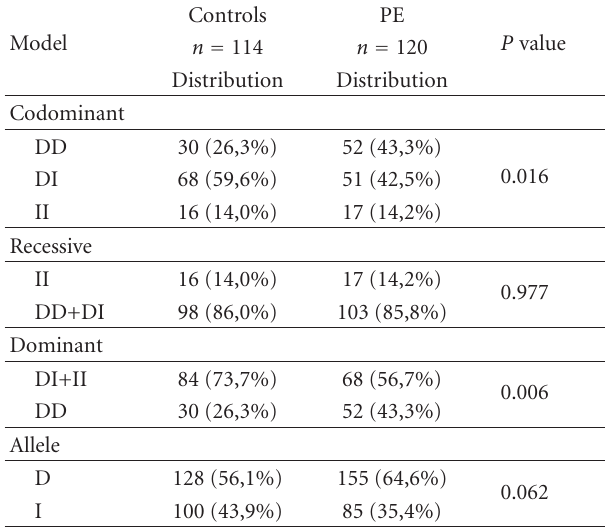
Table 2: Angiotensin-converting enzyme (ACE) polymorphism in normal pregnancies and in pregnancies complicated by preeclamp- sia